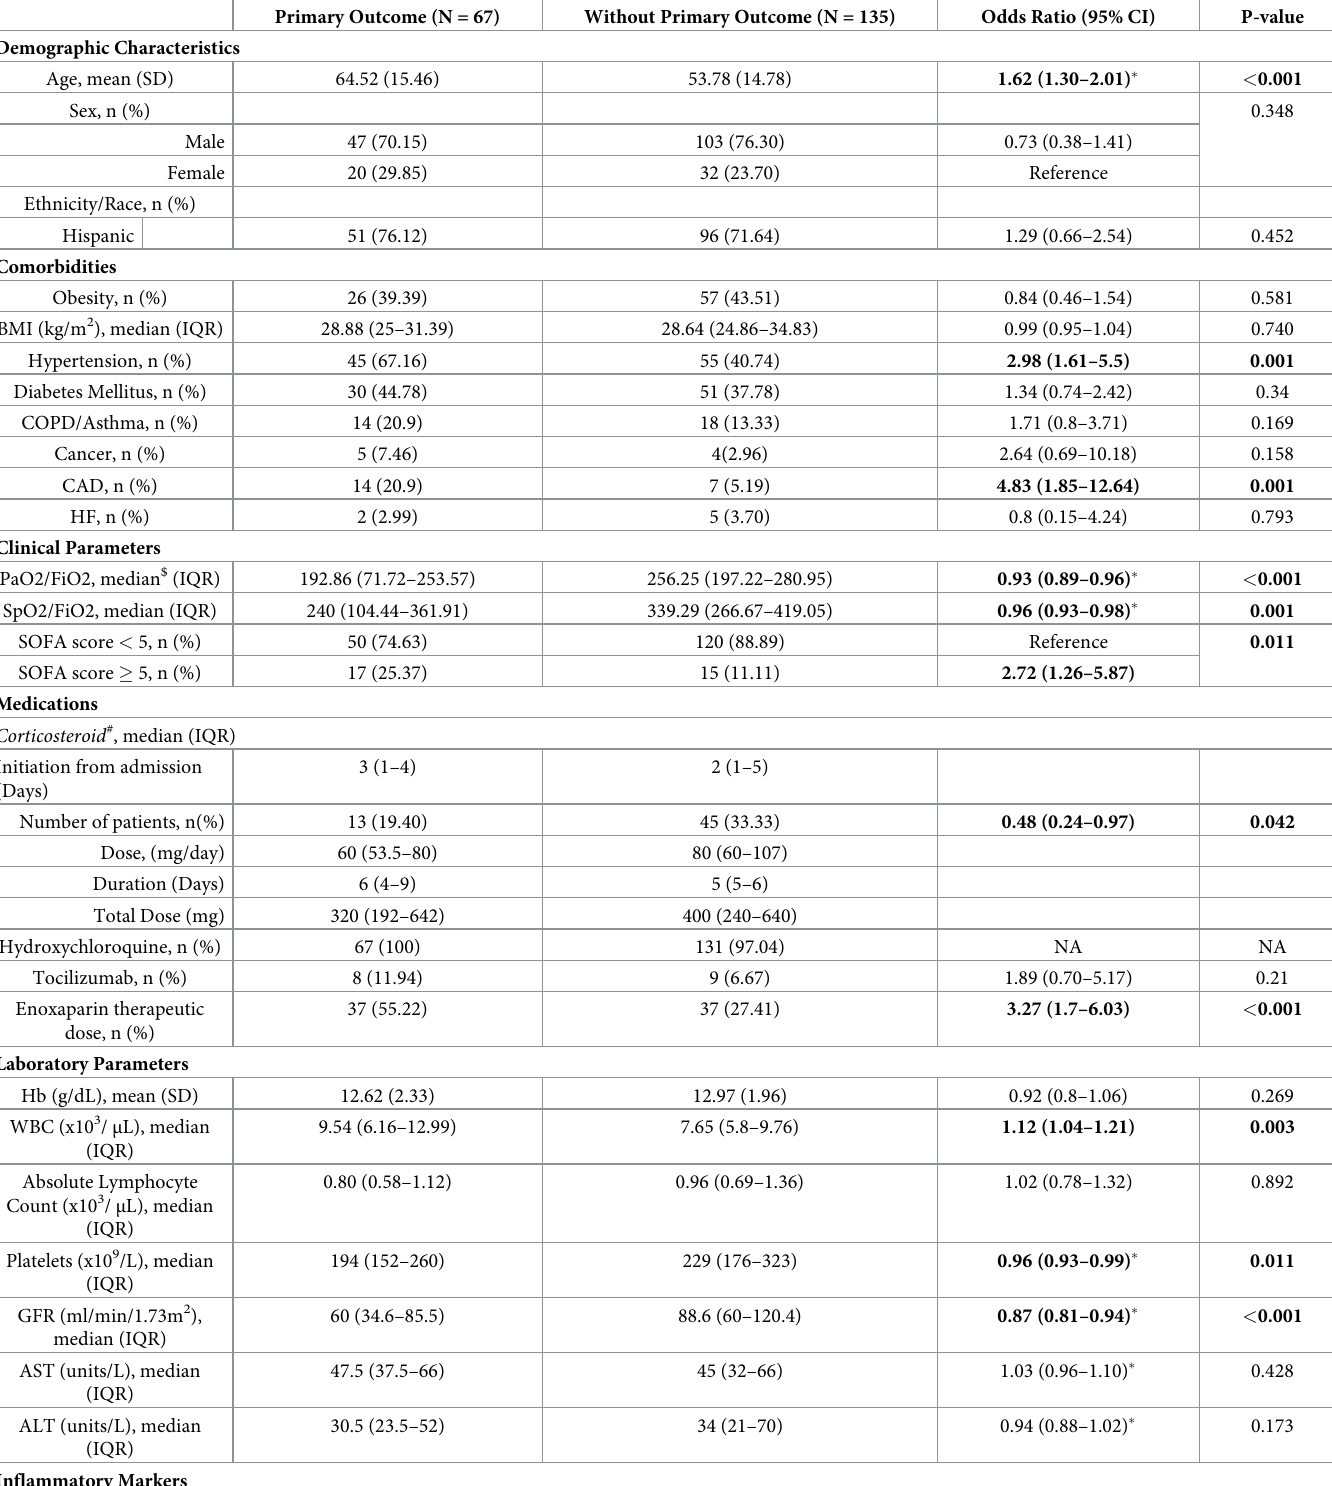
Table 2. Clinical and laboratory indices of patients with and without composite primary outcome (ICU transfer or intubation or